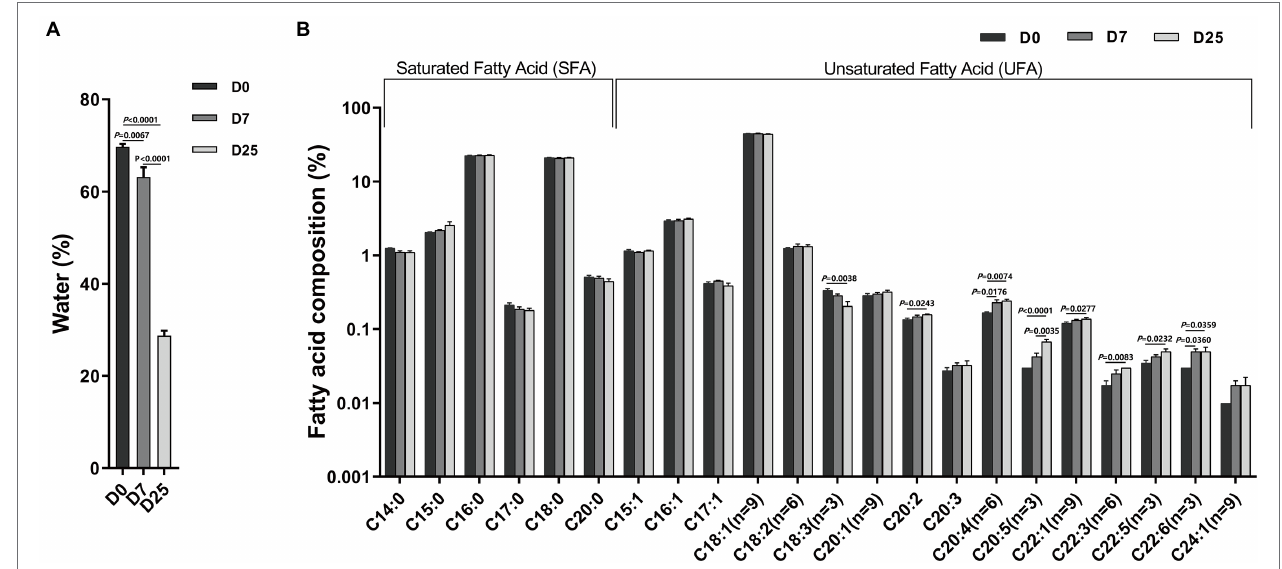
FIGURE 2 | The effects of overfeeding on water content (A) and fatty acid composition (B) in the livers of Landes geese. Liver samples were collected from geese overfed for 0, 7, and 25 days for the determination of water content and fatty acid composition. Data are expressed as the means ± SEM and analyzed by one-way ANOVA ( n = 10). The Y axis is a logarithmic coordinate axis. The number at the top of the column is the means. The number on the horizontal line indicate value of p . p < 0.05 was considered to indicate statistical significance. D0, overfeeding for 0 days; D7, overfeeding for 7 days; D25, overfeeding for 25 days.